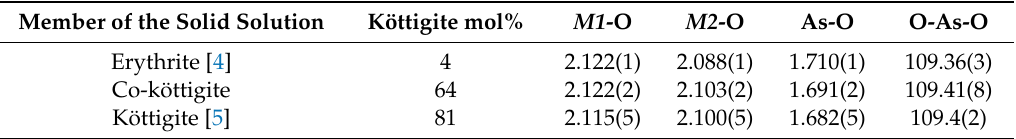
Table 6. Average M1 –O, M2 –O, and As–O bond distances (Å) and O–As–O angles ( ◦ ) in the erythrite–köttigite solid solution.